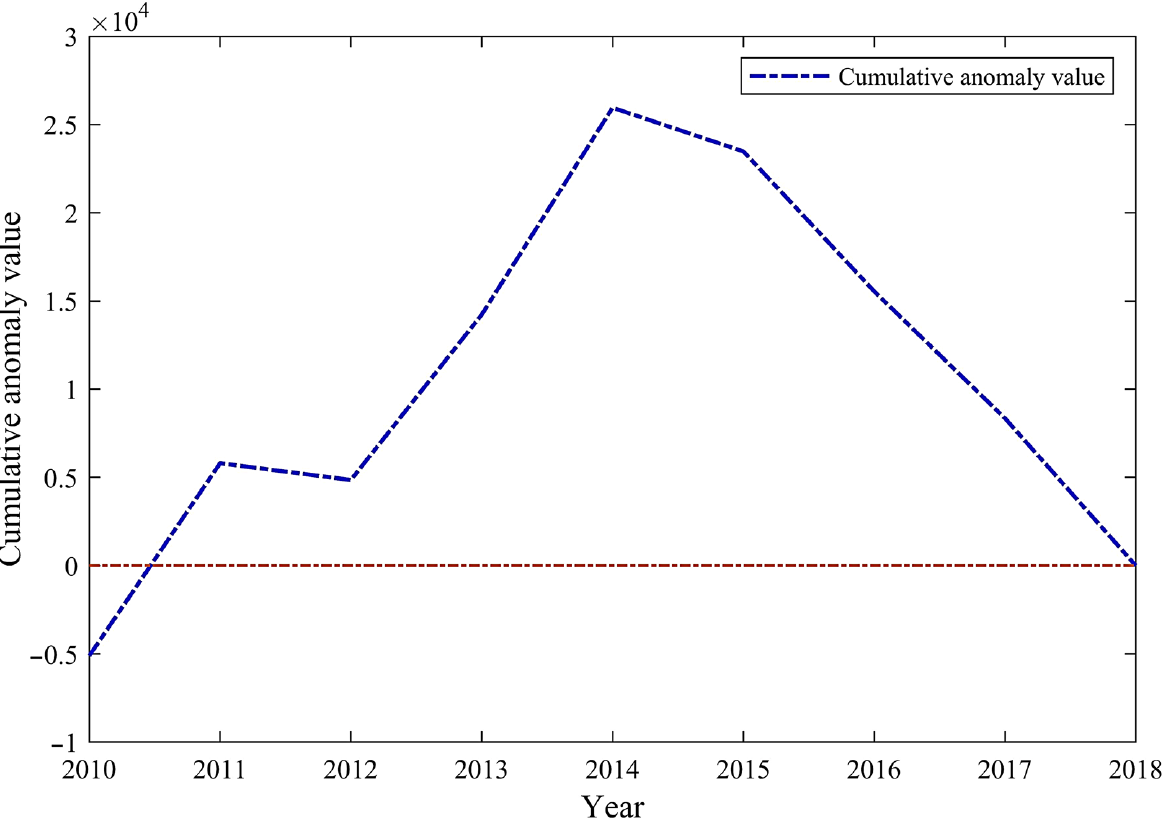
Figure 5. Cumulative-distance leveling curve. Table 1. Standard deviation for oval-shaped parameters of forest fire occurrence in mainland China,